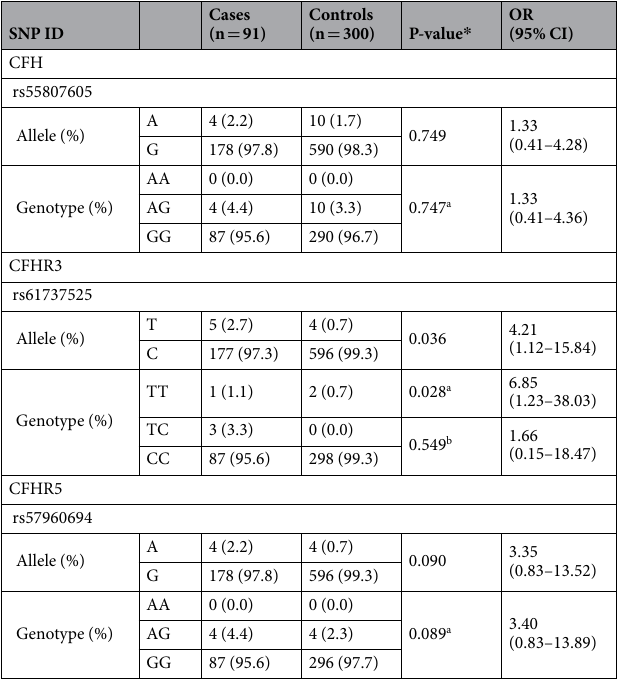
Table 1. Comparison of genotype and allele frequencies of CFH, CFHR3 and CFHR5 single nucleotide polymorphisms (SNPs) in patients with rare glomerular nephropathies and control subjects. n = number of subjects; OR = odds ratio; CI = confidence interval. Data shown are the number of subjects (% of the total group). * Fisher’s exact text. a P value for dominant model; b P value for recessive mode.